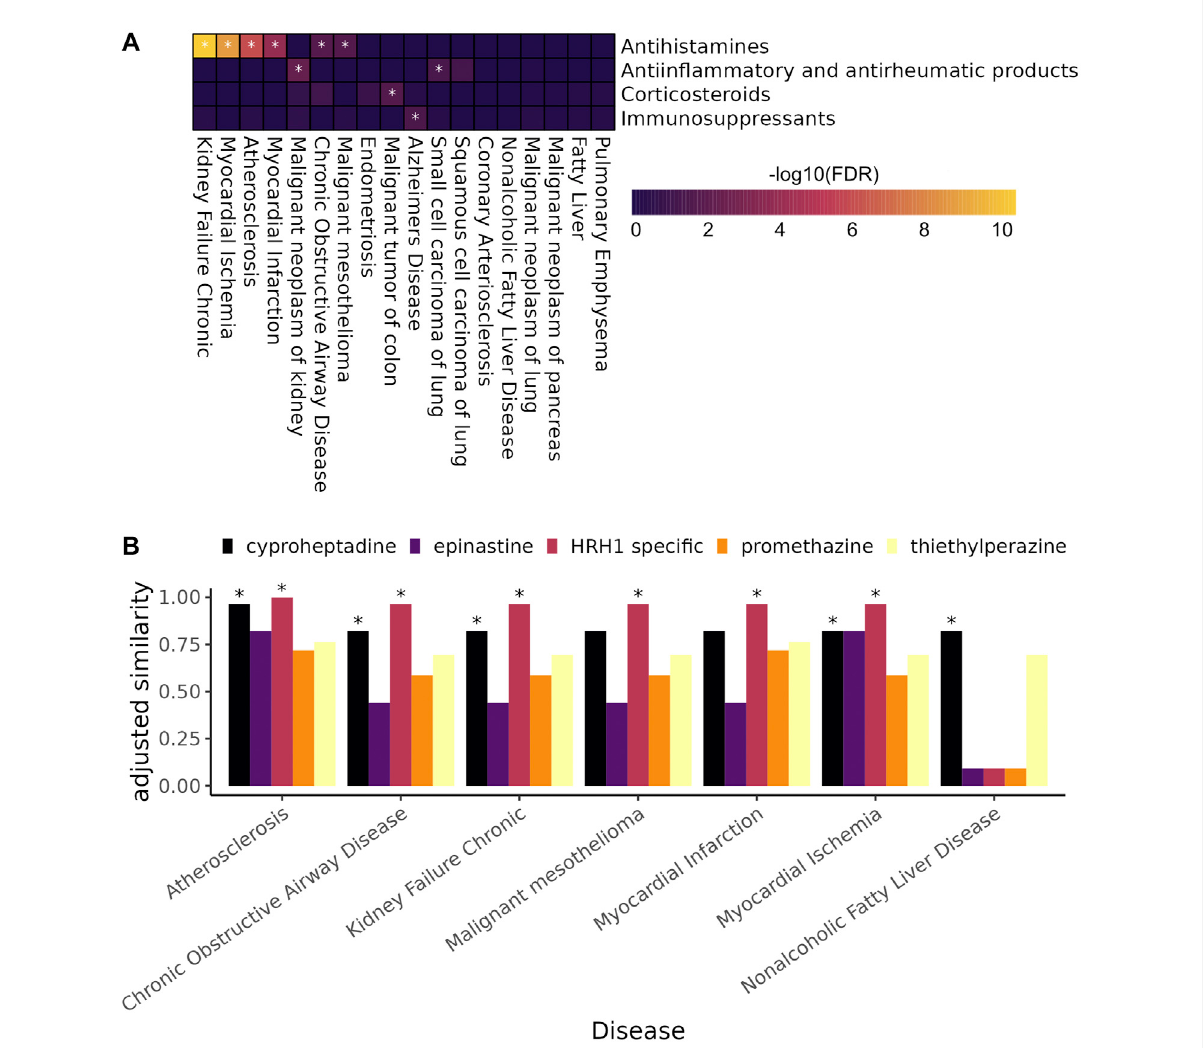
FIGURE 6 (A) Heatmapshowingtheenrichmentofanti-in fl ammatoryandimmunomodulatingdrugsamonghighlyrankedSAveRUNNERpredicteddrugs (gene set enrichment analysis, * denotes adjusted p − value < 0 . 05 ). (B) Bar plot showing the adjusted similarity scores of antihistamines for complex diseases with at least one antihistamine among drugs predicted by SAveRUUNER to treat the disease — * denotes FDR < 0 . 01 . HRH1 speci fi